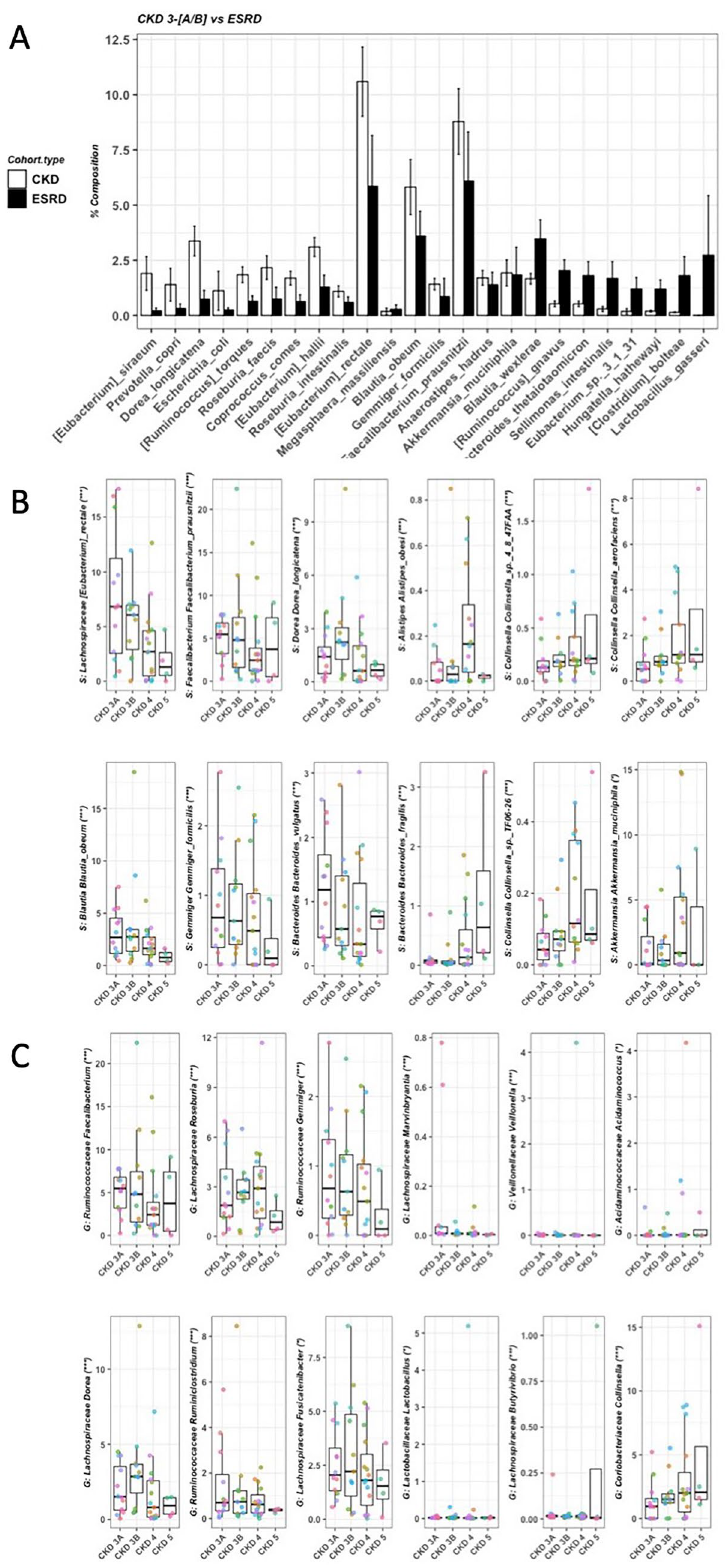
Figure 2. Microbial composition. ( A ) Significant microbial species between early stage CKD (n = 23) and ESRD patients (n = 10). Wilcox-rank sum test was used to calculate p-values and multiple testing was corrected using FDR. Relative abundance of microbial species > 1% in one of the subjects and with FDR < 0.1 were shown. ( B ) Microbial species significantly associated with the severity of CKD. Association was calculated by Maaslin2. Top six species showing negative and positive association with disease severity were shown. ( C ) Microbial genera significantly associated with the severity of CKD. Association was calculated by Maaslin2. Top six species showing negative and positive association with disease severity were shown. ***FDR < 0.0005; **FDR < 0.005; *FDR <